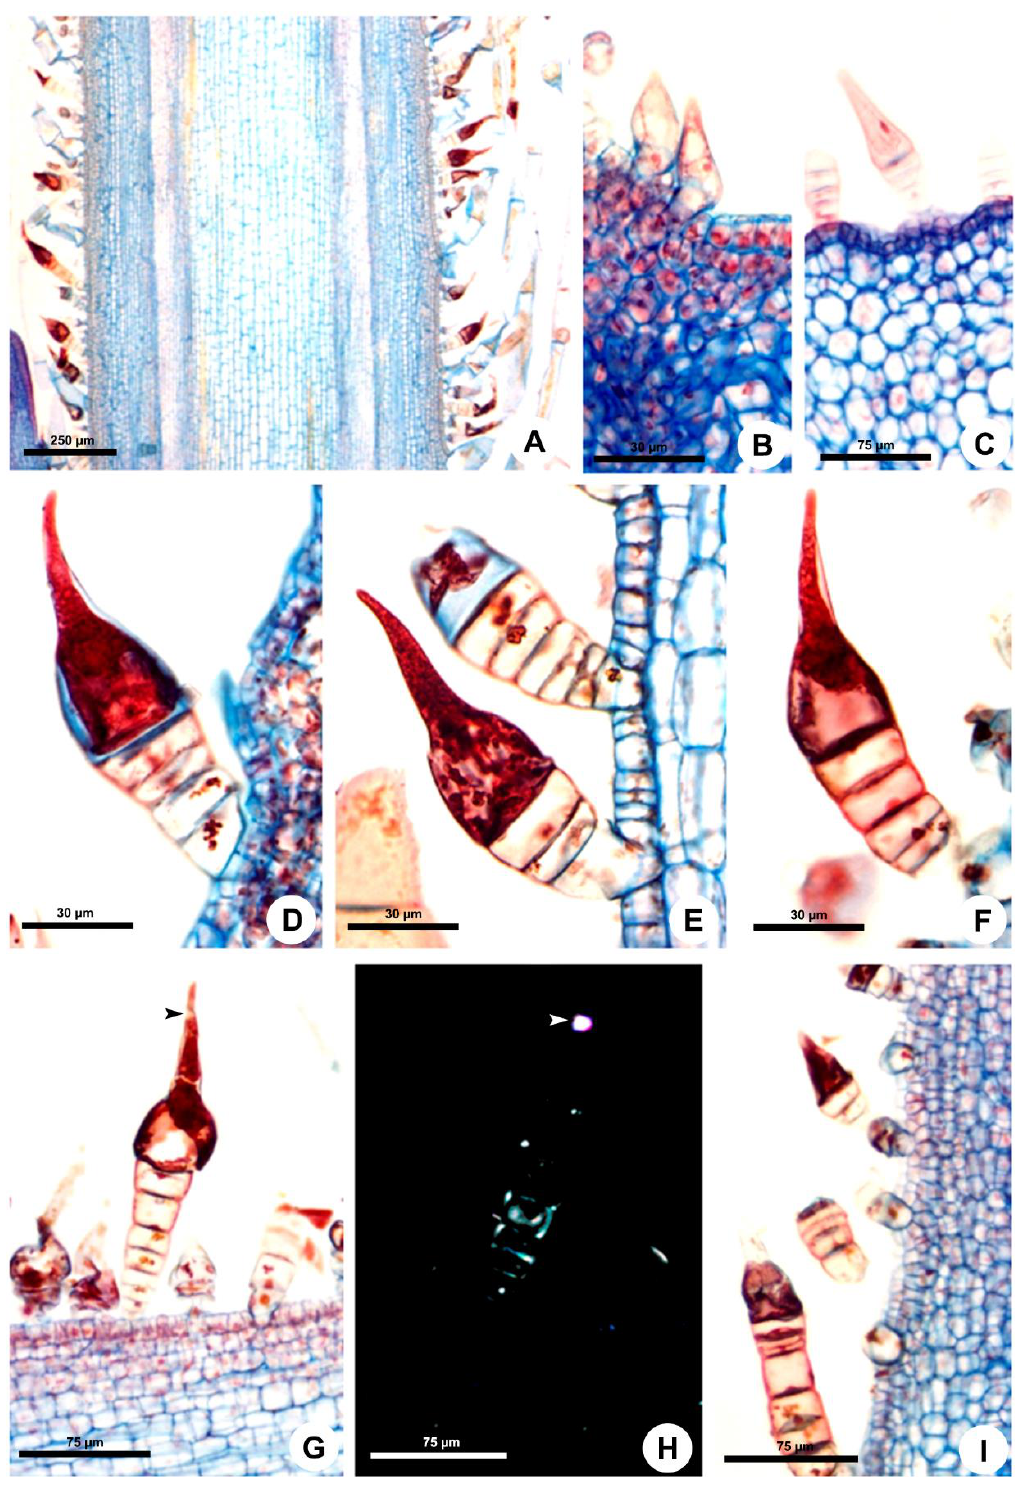
Figure 2. Ontogeny and structure of the stinging trichomes of Fischeria stellata . ( A , B , D – I ) Longitudinal sections. ( C ) Cross section. ( A ) Trichomes on the young stem. ( B , C ) Origin of the stinging trichomes on leaf primordia. ( B ) and primary stem ( C ). ( D ) Beginning of secretory activity. Note the dense aspect of the cytoplasm. ( E ) Secretory vesicles in the cytoplasm. ( F ) Mature trichome with vacuole in the basal region of the secretory cell and cytoplasmic contents in its acuminate region. ( G , H ) Mature stinging trichomes. Note the crystals (arrowhead) and the stalk with secondary walls evidenced by polarized light ( H ). ( I ) Stinging trichomes with the apex broken.